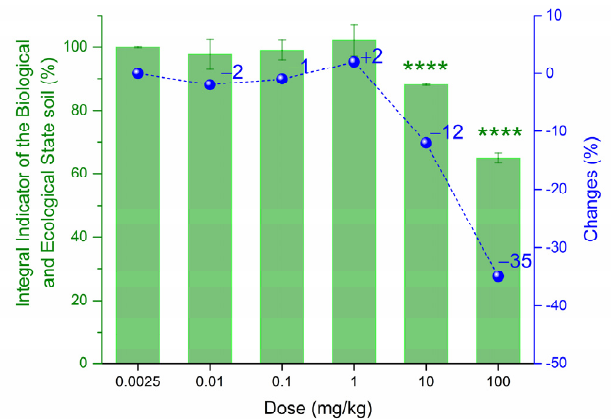
Figure 4. Effect of PtNPs on the integral indicator of the biological state of Haplic Cambisols Eutric with its relative changes compared to the control. (**** p ≤ with its relative changes compared to the control. ( **** p ≤ 0.0001).